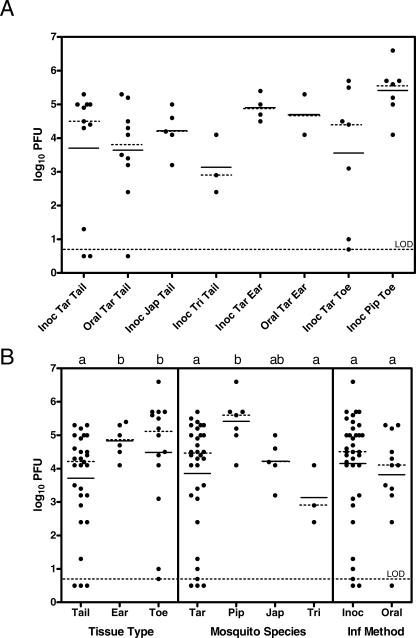
Mosquitoes Inoculate High Doses of WNV In Vivo under Various Experimental Conditions(A) WNV doses inoculated extravascularly by mosquitoes. x-Axis labels indicate mosquito infection method (Inoc = intrathoracic inoculation, Oral = orally infected), mosquito species (Tar = Cx. tarsalis, Pip = Cx. pipiens, Jap = Ae. japonicus, Tri = Ae. triseriatus), and tissue in which the mosquito probed or fed in (Tail = mouse tail, Ear = mouse ear, Toe = chick toe). Limit of detection (LOD) of plaque assay is shown.(B) Same data as in (A) but pooled by tissue type, mosquito species, and infection method. Within each larger grouping (tissue type, mosquito species, or infection method), groups designated with different lower case letters (above graph) are significantly different from one another (p < 0.05 by Mann-Whitney or Kruskal-Wallis tests). Solid line shows mean titer, and dashed line shows median titer, for each group.